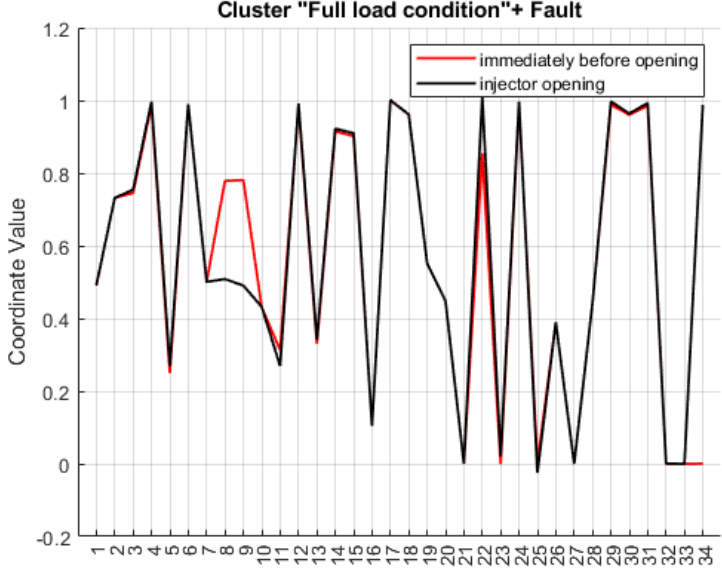
Figure 14. Comparison between cluster A (red) and cluster C (black) centroid coordinates. SC with pairwise